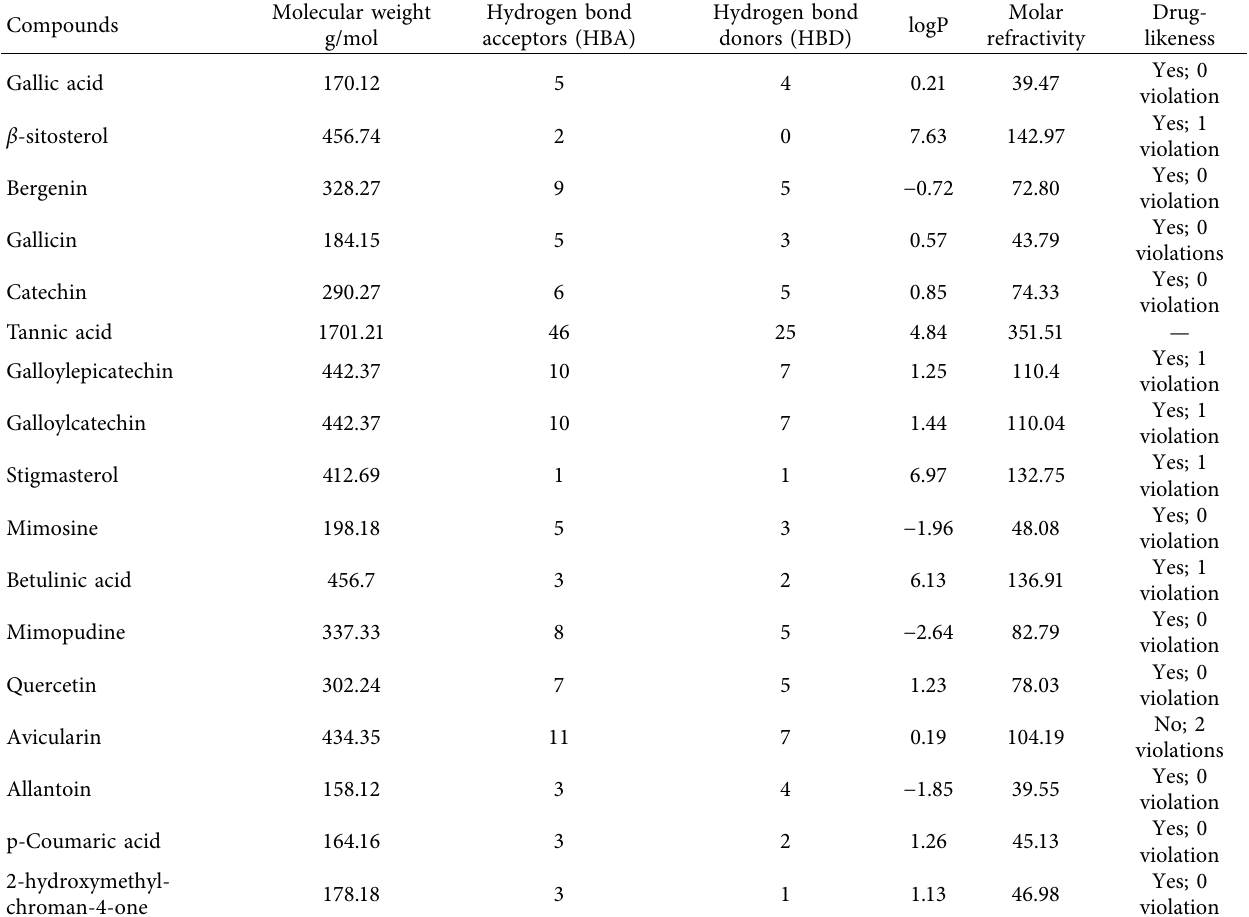
Table 5: Physiochemical and drug-likeness properties of